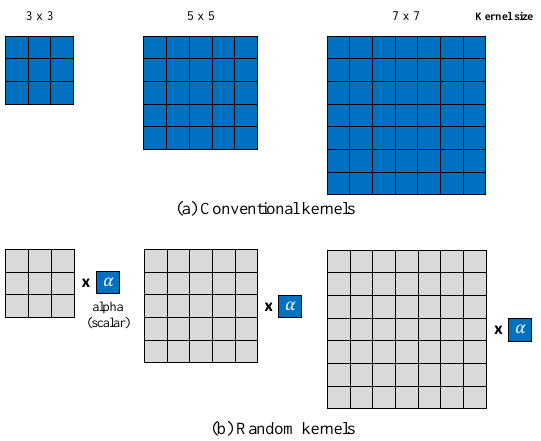
Figure 2. Comparison of the number of parameters between the conventional and our proposed ran- dom kernel in the spatial domain. Blue : trainable weight parameters. Gray : non-trainable weight pa- rameters. ( a ) Conventional kernels. ( b ) Random